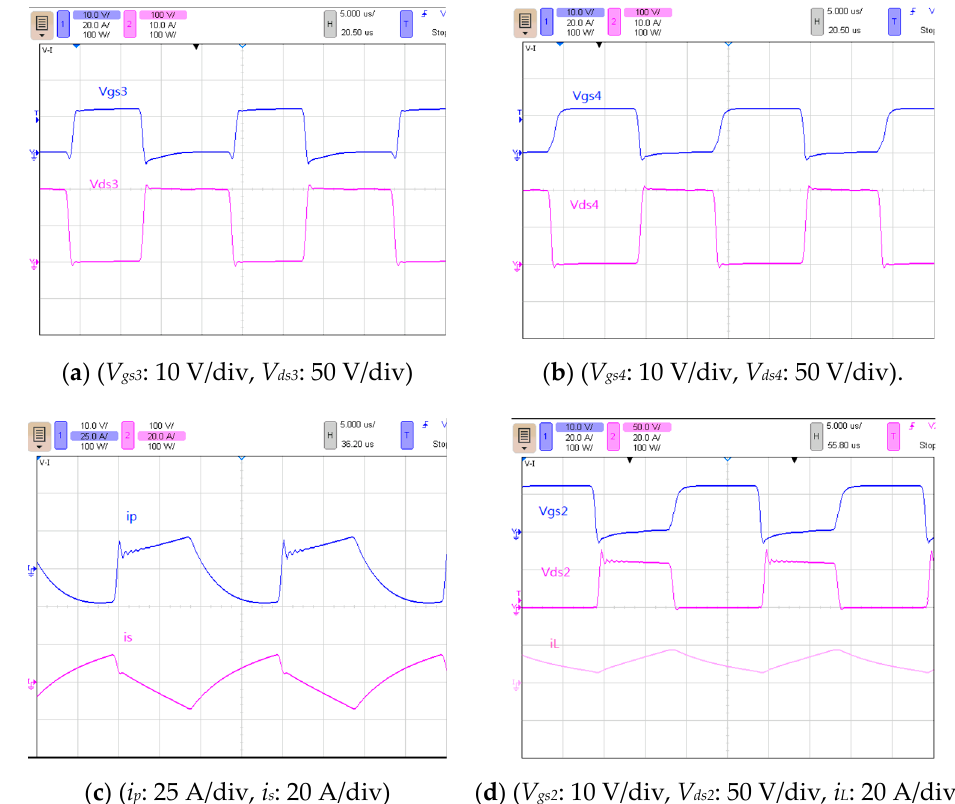
Figure 14. Measured waveforms under Stage 3 of full load: ( a ) switch S 3 waveform, ( b ) switch S 4 waveform, ( c ) current waveform of transformer, and ( d ) switch S 2 waveform and charging inductor current